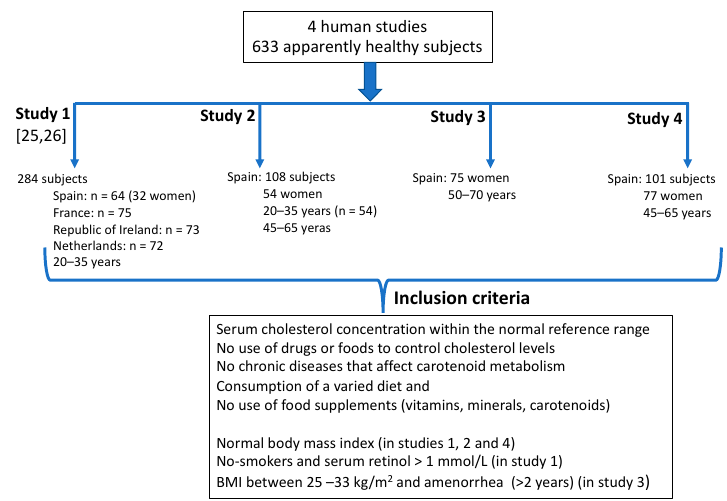
Figure 1. Human studies conducted by our research group.